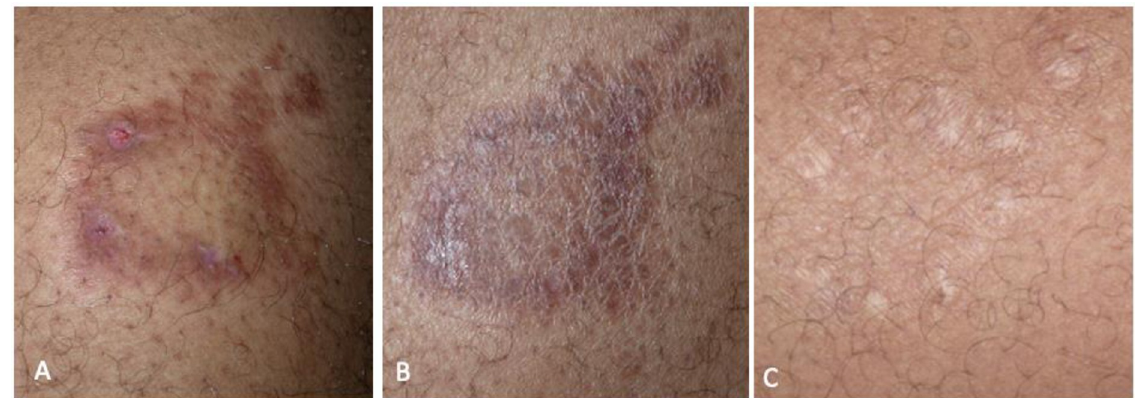
Fig 2. IRIS type 1 after introduction of HAART in patient 3: TT on left flank. A: at diagnosis of leprosy; B: on MDT and HAART; C: cured at M18 (continued MDT and HAART).